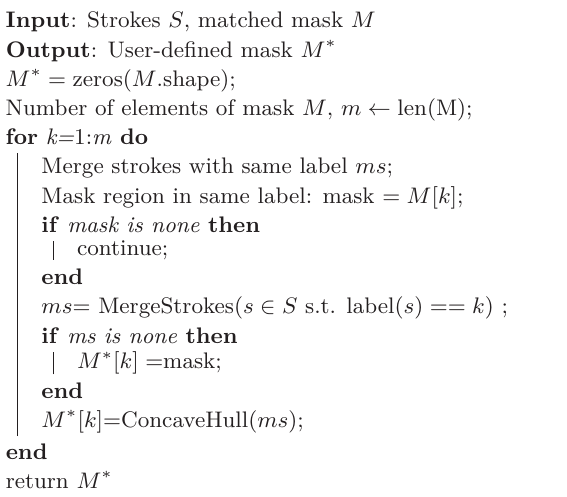
Algorithm 1 Sketch-to-mask